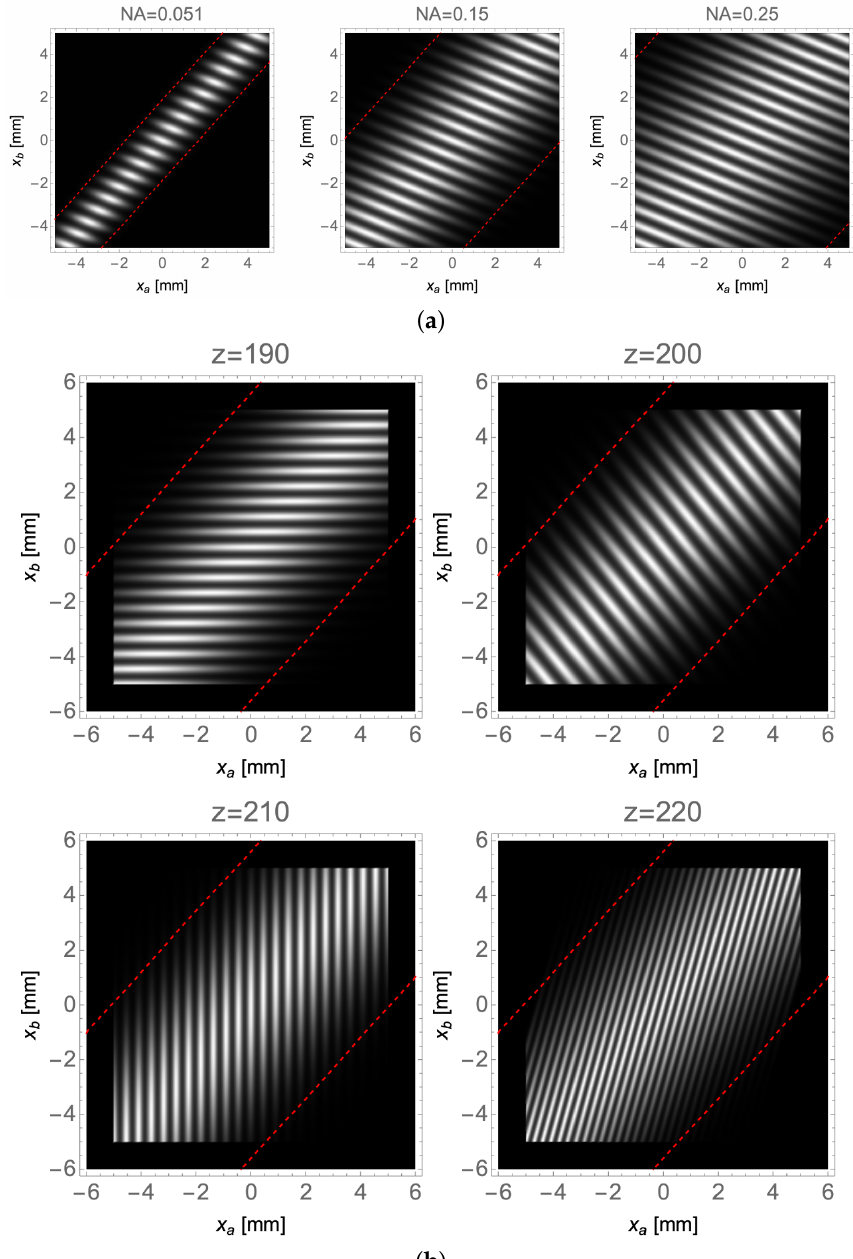
Figure 3. ( a ) Study of the effect of the numerical aperture (NA) of the lens on the extension of the correlation function in the ( x a , x b ) plane. The numerical aperture is changed by varying the lens aperture l . With reference to Figure 2a, the object was placed at a distance z = 195 mm (cid:54) = z a , b from the lens. The area enclosed between the red dashed lines represents the lens extension (in this region, the lens aperture function, whose values vary in ( 0,1 ) , is larger than 0.001). ( b ) The effect of the displacement of the object along the optical axis, at a fixed lens numerical aperture of 0.15. Four axial positions of the object were explored. When the sample was placed in either one of the two planes of focus ( z = z a = 190 mm and z = z b = 210 mm), the replicas of the details appearing in the correlation function line up either horizontally or vertically. When z = 200 mm the object was placed between the two planes focused on D A and D B ; while z = 220 mm corresponds to a sample placed farther away from the lens than the farthest plane focused on D A and D B